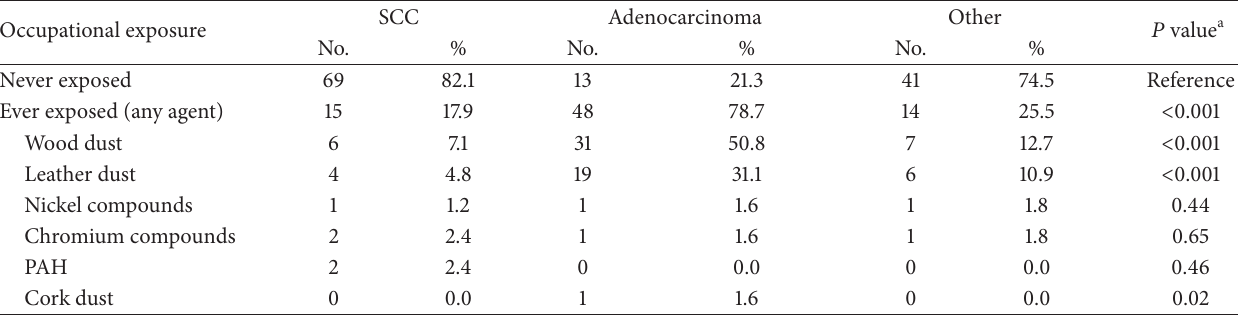
Table 3: Occupational exposure to carcinogenic agents among subjects with sinonasal cancer, by tumor morphology; Lombardy region sinonasal cancer registry, 2008–2011 ( 𝑁 = 200 with